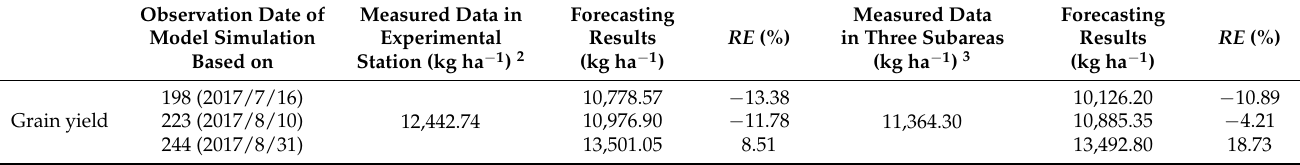
Table 3. Comparisons between the forecasted grain yields based on the field observations in different days and the measurements 1 in three subareas and experimental